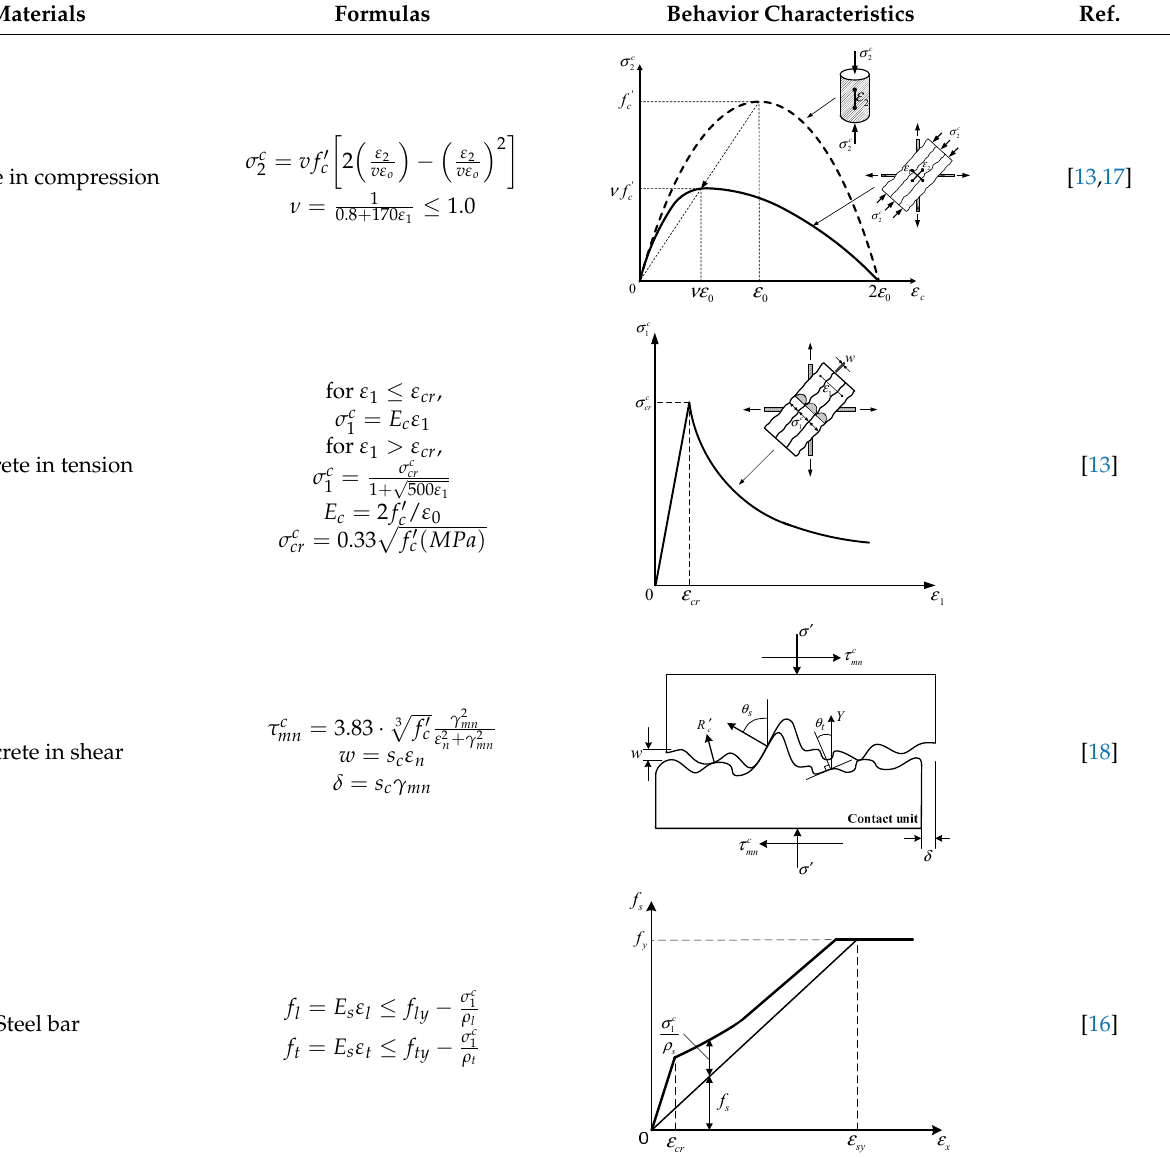
Table 2. Constitutive laws of materials used in shear analytical model. Materials Formulas Behavior Characteristics Ref.